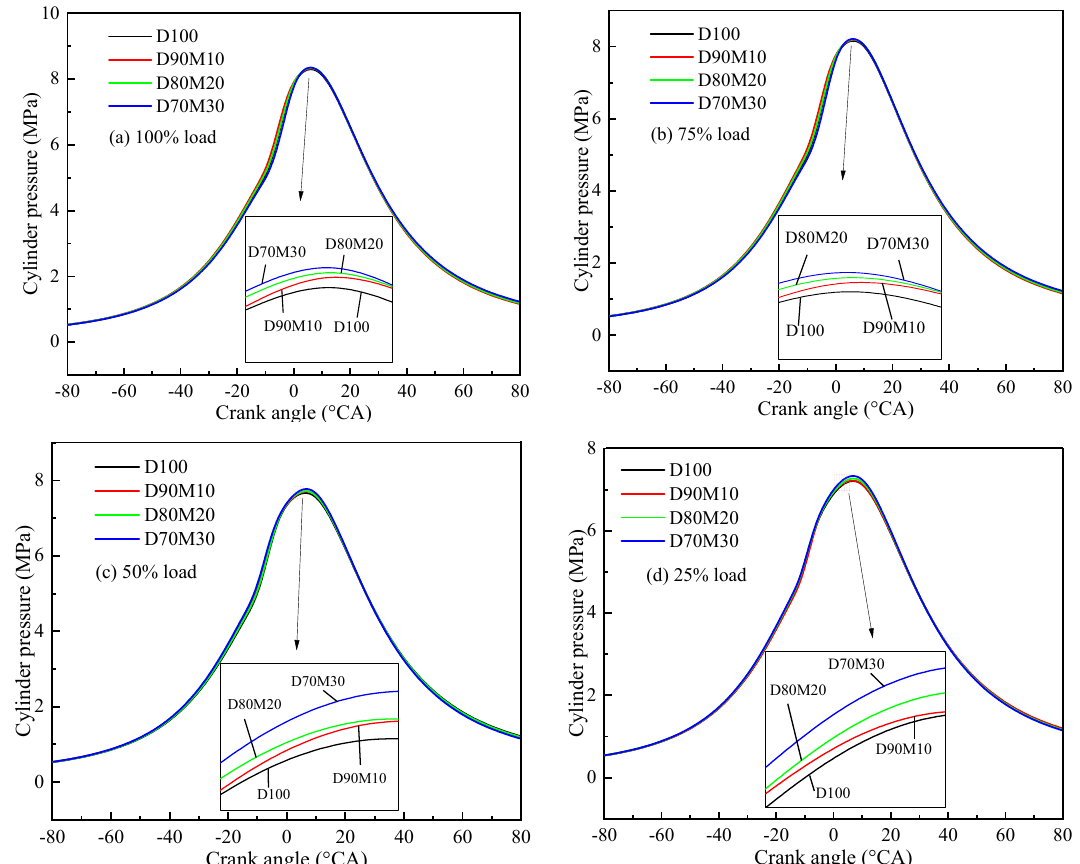
Figure 6. Cylinder pressure curves of different proportions of diesel–methanol blended fuel under different load conditions. ( a ) at 100% load, ( b ) at 75% load, ( c ) at 50% load, ( d ) at 25% load.